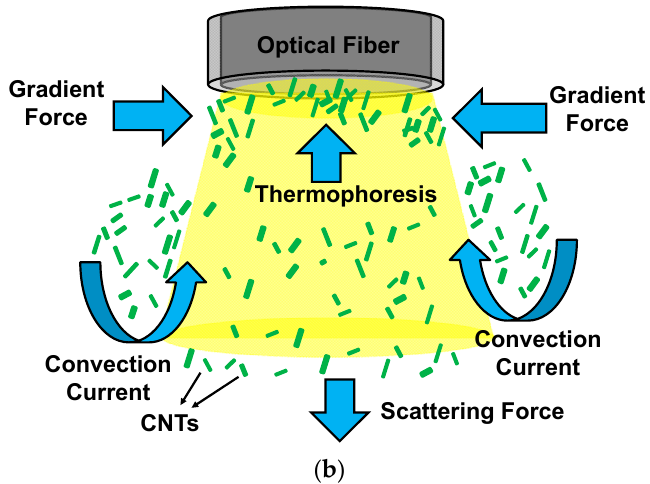
Figure 4. ( a ) Schematic of the experimental set up for optical deposition of CNTs onto an optical fibre sensing probe; ( b ) Illustration of the various physical effects which would result in the deposition of CNTs onto the end-face of an optical fibre.